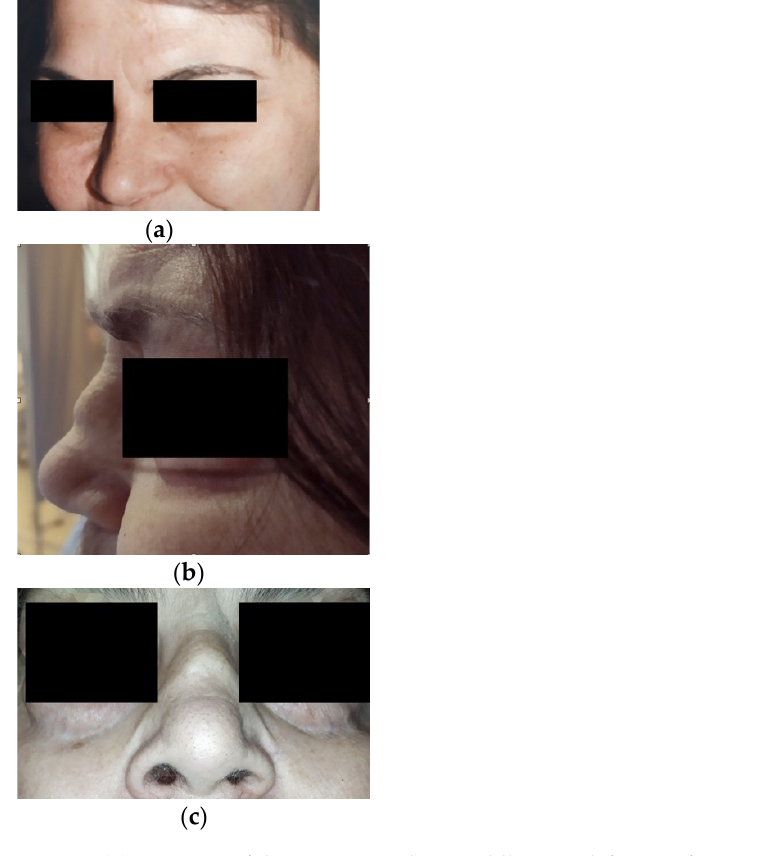
Figure 1. ( a ) A picture of the patients without saddle-nose deformity five years prior to presentation; ( b , c ) saddle-nose deformity upon presentation .